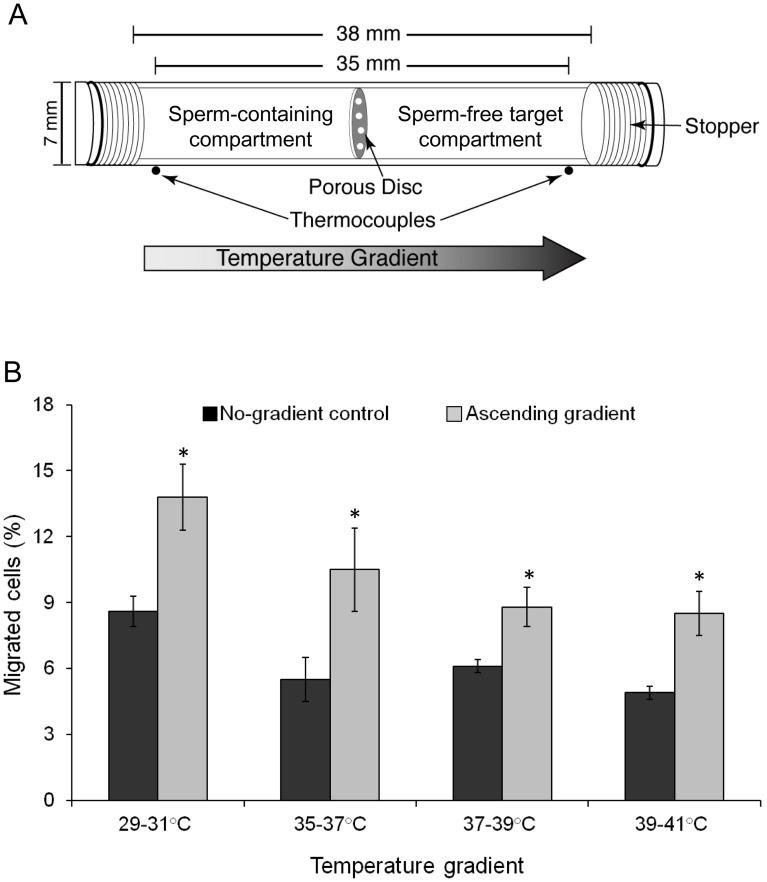
Migration of human spermatozoa in an ascending temperature gradient.
A: Schematic illustration of the Lucite tube composed of two compartments for the separation process [5]. Thermocouples at both ends of the tube holder measured the temperatures at these locations. The two compartments were separated by a thin disc (316 stainless steel) having pores, 40 µm in diameter. B: Migration at various temperatures. The results are the mean ± SEM of 6–19 determinations (3–4 experiments for each temperature gradient tested). The temperatures shown in the abscissa were those measured by the thermocouples at both ends of the tube (externally to the tube). Asterisks above the columns indicate a statistically significant difference from the respective no-gradient control (P≤0.02, according to Student’s t-test).